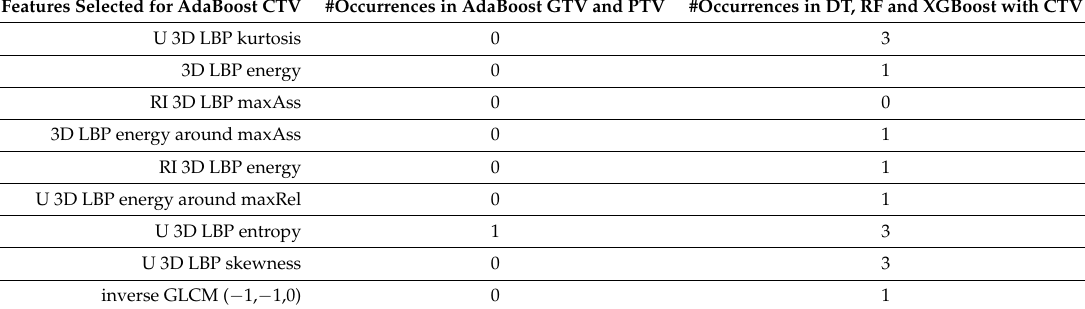
Table 4. Best radiomic signatures. The fist column lists the feature selected in the best performance. The other two columns indicate the number of times that each descriptor was selected in the best feature set. Abbreviations: U—uniform, RI—rotation invariant.